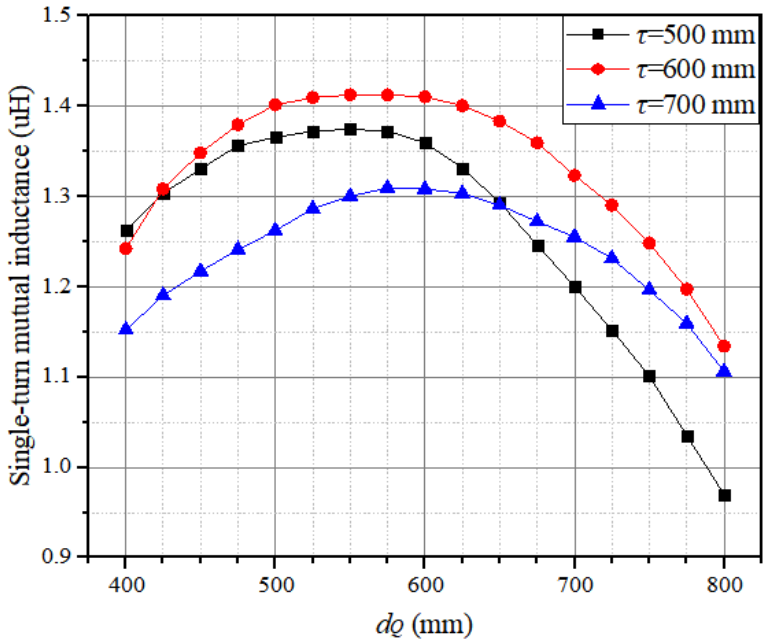
Figure 6. The single-turn mutual inductance of winding Q with different d Q and τ values.